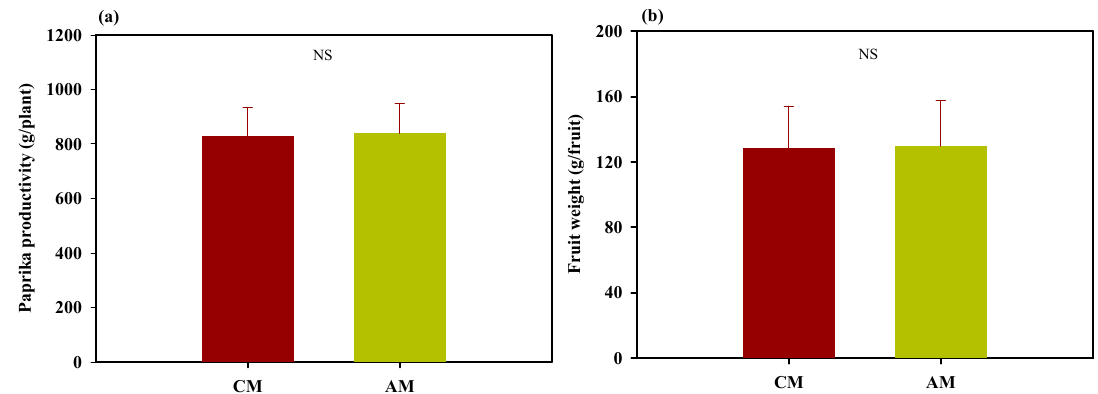
Figure 9. Comparisons (mean ± SD) of total yield ( a ) and fruit weight ( b ) of sweet pepper during the experimental period between conventional (CM) and alternative (AM) nutrient-replenishment methods ( t -test). NS: Not significant ( P > 0.05); n = 10 per treatment. In the case of blossom-end rot, the mean value was low in the AM but not by a significant di ff erence (Figure 10). This is considered to be due to the di ff erence in concentration of the root zone when considering the characteristics of sweet pepper responses to root zone nutrient concentration [38].